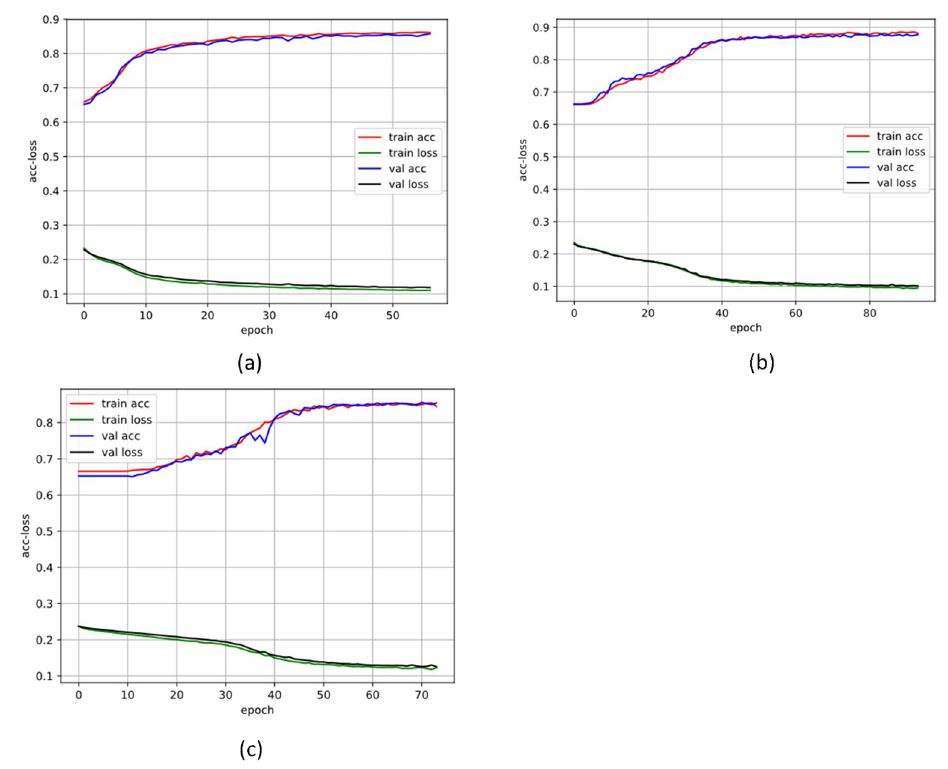
Figure 9. Training and validation loss function over the epochs (DB2). ( a ) The 500 length segment; ( b ) the 1000 length segment; ( c ) the 2000 length segment.